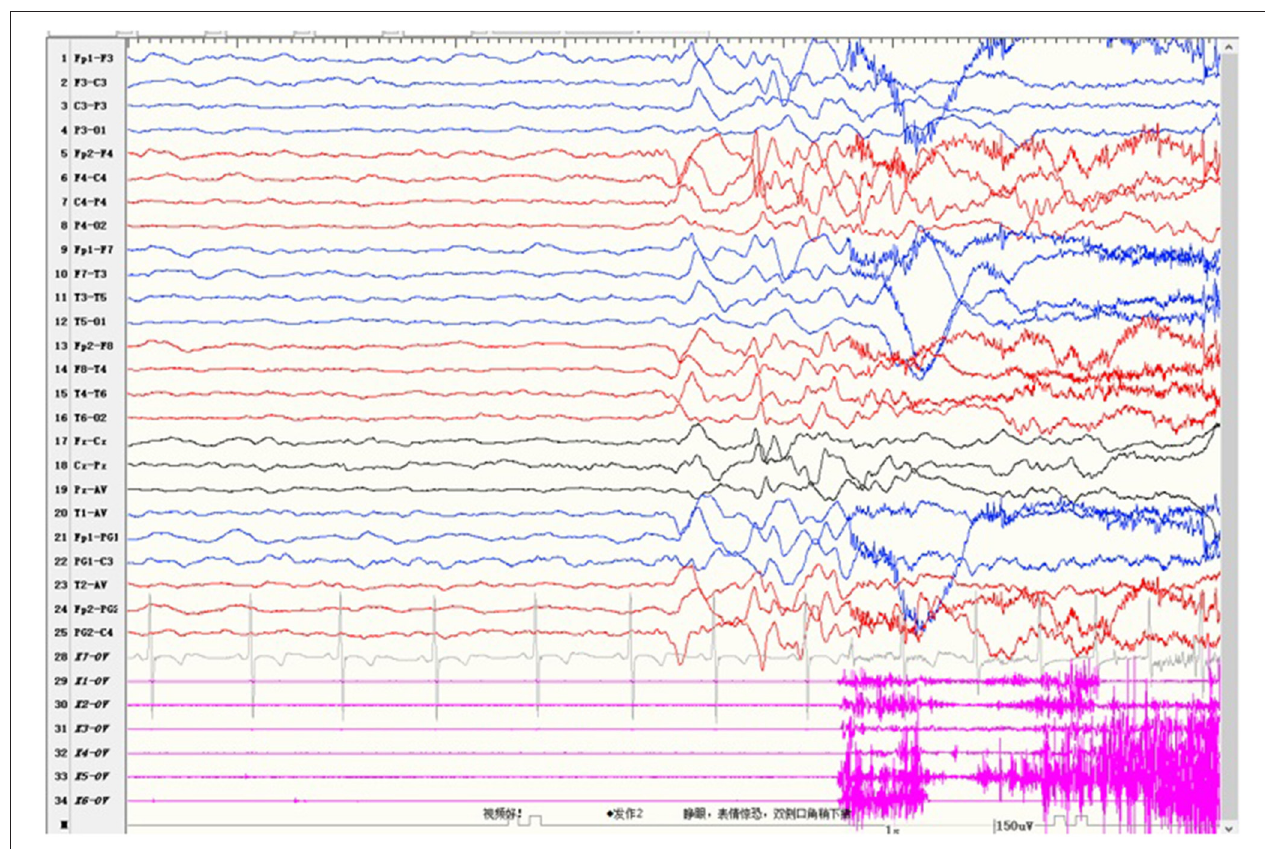
FIGURE 1 | Ictal electroencephalogram of case 2 showed the seizure onset from the right hemisphere.